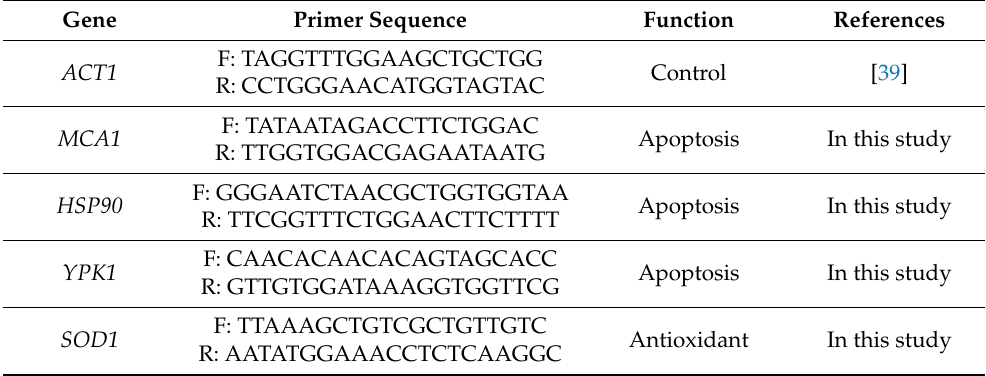
Table 1. List of qRT-PCR